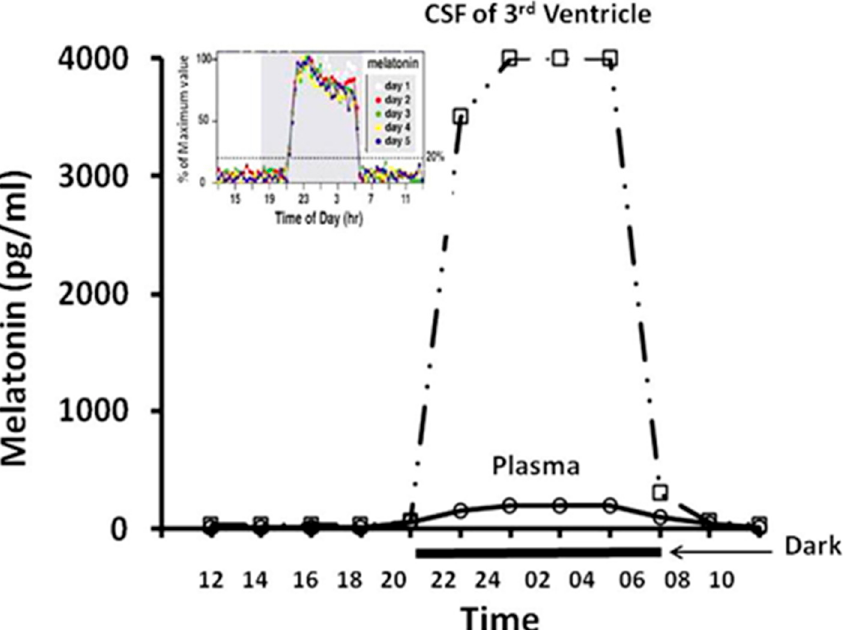
Figure 2. The different levels and shapes of melatonin circadian rhythms in the CSF of the third ventricle and in the peripheral blood. The nightly melatonin levels in CSF of the third ventricle are more robust than those in the peripheral plasma and also exhibit sharp rises and falls (square wave). The pattern of the melatonin circadian rhythm in CSF of the third ventricle is similar to that of the pineal gland rather than in the plasma (see the insert part which illustrates the melatonin synthetic pattern in pineal gland of rat). The data was obtained from the long term (5 days) pineal gland dialysis in a free running rat. Extrapineal-generated melatonin and the diet-derived melatonin may increase peripheral plasma melatonin levels; however, they do not mimic the pattern and reach the high level of the melatonin circadian rhythm in the CSF of the third ventricle to impact the function of bio-clock. From Tan et al. [63].